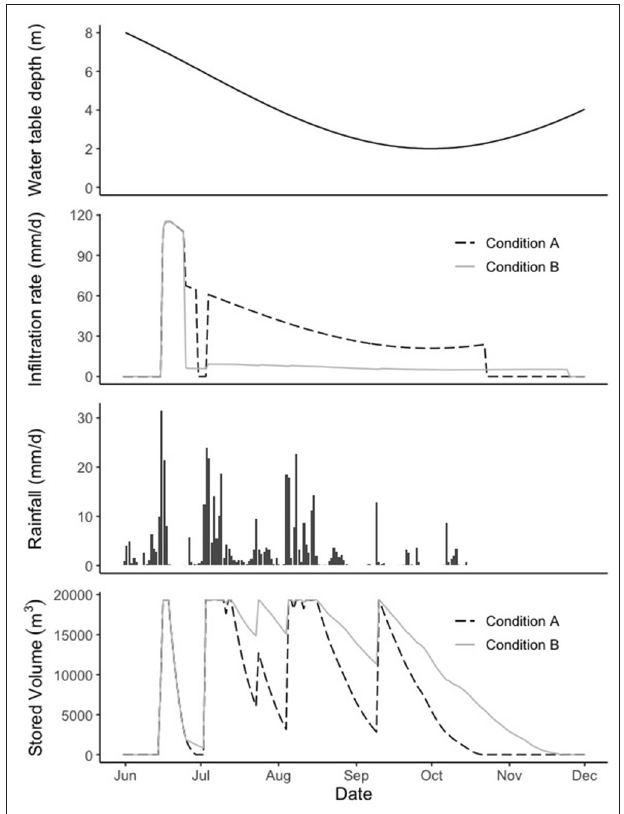
FIGURE 6 | Daily hydrological behavior for the year 2001, normal year (from above: depth to the water table, infiltration rate, daily rainfall, and stored water volume in the dam).